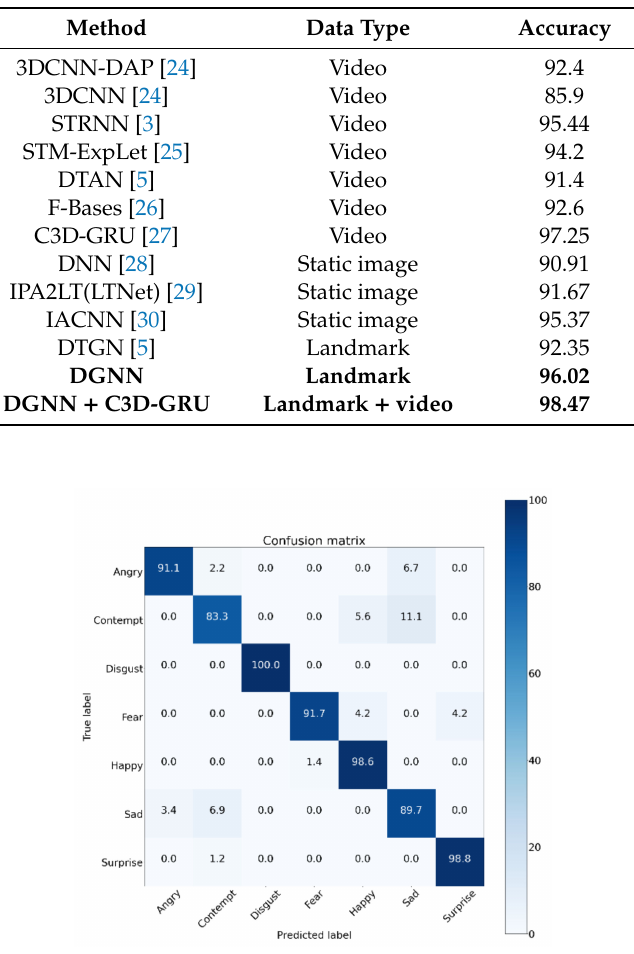
Table 1. Experimental results for the CK + dataset. The proposed methods are highlighted in bold.